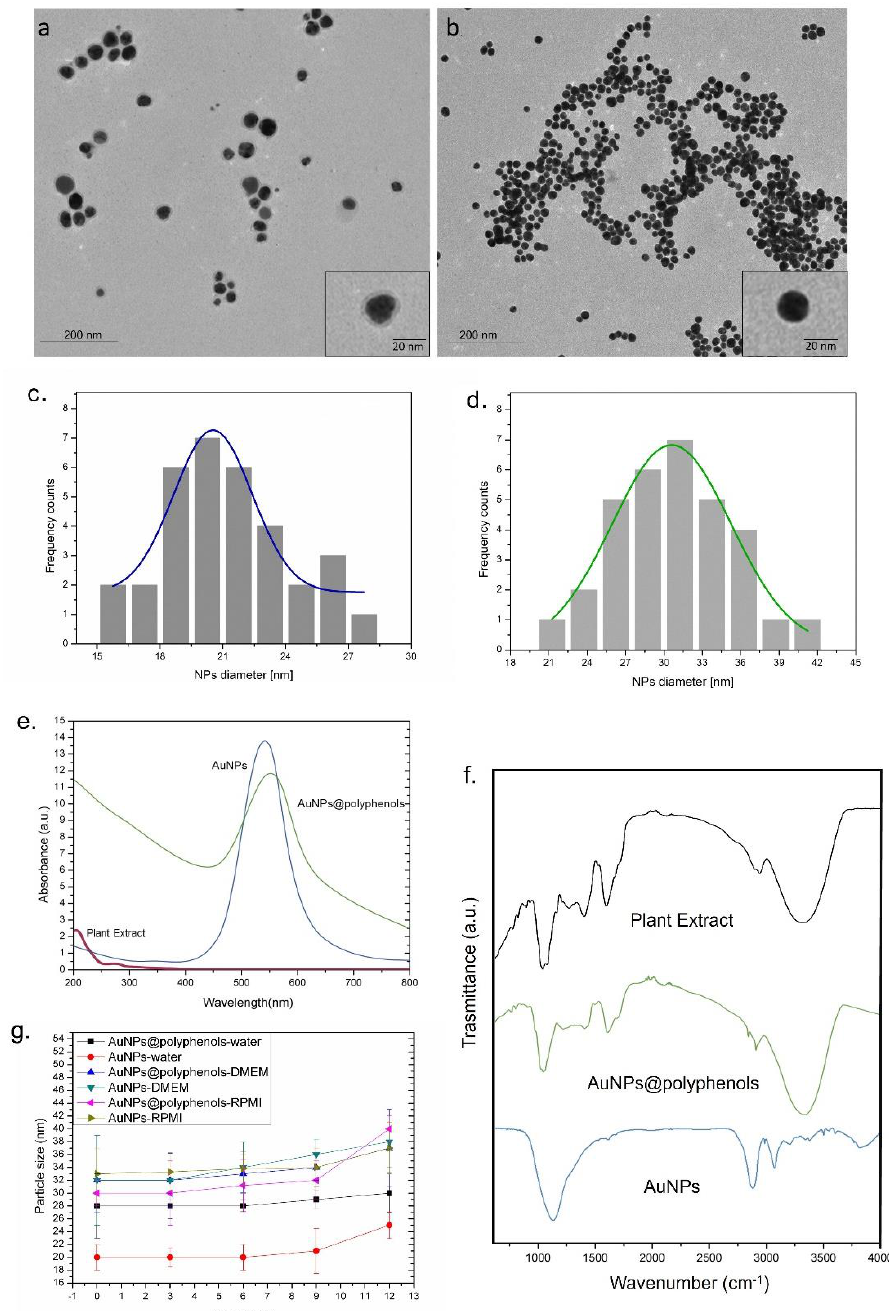
Figure 1. Representative TEM images of Au NPs@polyphenols ( a ) and conventional Au NPs ( b ); Statistical analysis with Gaussian fit (black line) for Au NPs@polyphenols ( c ) and Au NPs ( d ); UV-vis ( e ) and FTIR measurements ( f ) conducted on plant extract, Au NPs@polyphenols and Au NPs. Stability studies ( g ) of Au NPs@polyphenols and conventional Au NPs in water, DMEM and RPMI, measured by DLS and acquired after 0, 3, 6, 9, and 12 days. The concentration used was 2 μM. To understand the quantity of polyphenols involved in the green synthesis, the total polyphenol concentration was measured on plant extract and on the Au NP@polyphenol water solution by the Folin-Ciocalteu method. We quantified (27 ± 3.7) mg/L from the plant extract and (15 ± 2.4) mg/L from the Au NP@polyphenol samples. The TEM images and the total polyphenols measurements confirmed the presence of polyphenols on the Au NPs (Table 1).